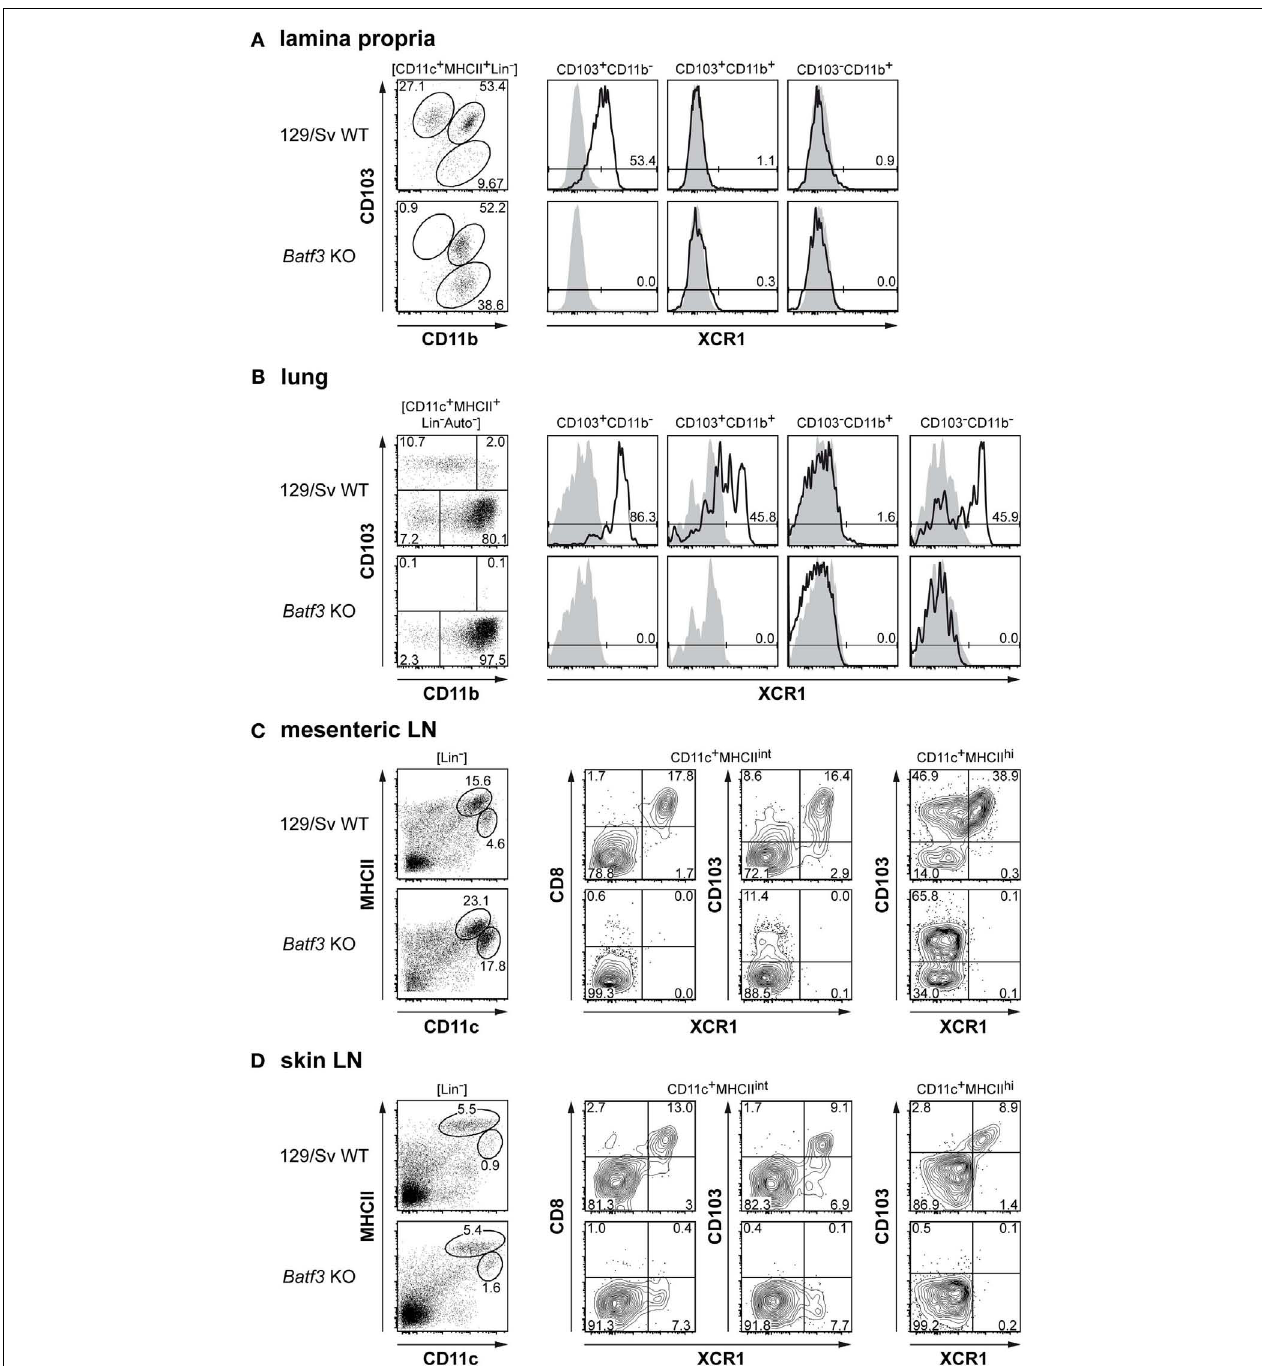
FIGURE 7 | Batf3 -deficient mice lack XCR1 + DCs in peripheral non-lymphoid and lymphoid tissues. (A) Expression of XCR1 (black histograms) on gut lamina propria cDCs (CD11c + MHC II + Lin − ) subdivided into CD103 + CD11b − , CD103 + CD11b + , and CD103 − CD11b + subsets in 129/SvWT controls (upper row) and Batf3 -deficient mice (lower row); the background signal (shaded histograms) was determined using homozygous B6.XCR1-lacZ mice. (B) Expression of XCR1 on lung cDCs (CD45 + CD11c + MHC II + Lin − autofluorescence negative) subdivided into